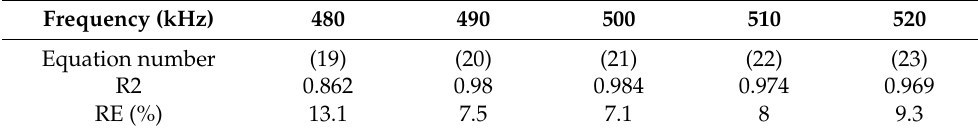
Table 9. Values of R2 and REs in NP2 (I) without the first values before the trend reversal occurs.